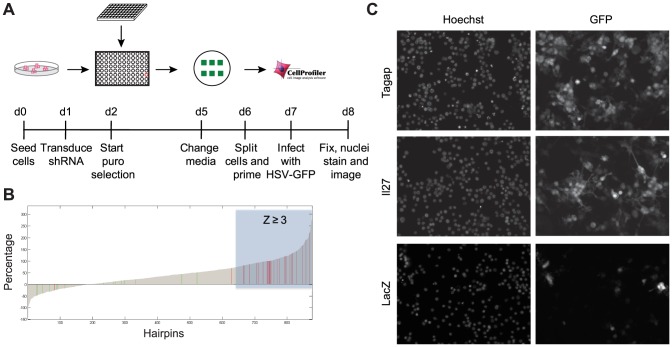
Loss-of-function genetic screen identifies positive regulators of antiviral responses.
(A) Protocol schematic of the primary genetic screen. (B) Ranked range normalization plot of the 827 shRNA of interest and controls. Range normalized HSV-GFP infection efficiency for each individual shRNA-transduced well, expressed as percentage within range 0 to 1, is ranked from low to high and displayed. Green bars indicate normalized irrelevant shRNA controls and red bars indicate normalized positive controls. Grey bars represent normalized shRNA targeting individual genes within T1D susceptibility loci. Location of shRNAs with a Z score equal or greater than 3 is indicated by the area shaded in blue. (C) Representative images are shown for two high-scoring shRNAs that target Tagap and Il27 respectively, and one irrelevant shRNA that targets lacZ. Hoechst nucleic acid stain indicates the total cells per microscopic field and GFP indicates the virally infected cells.